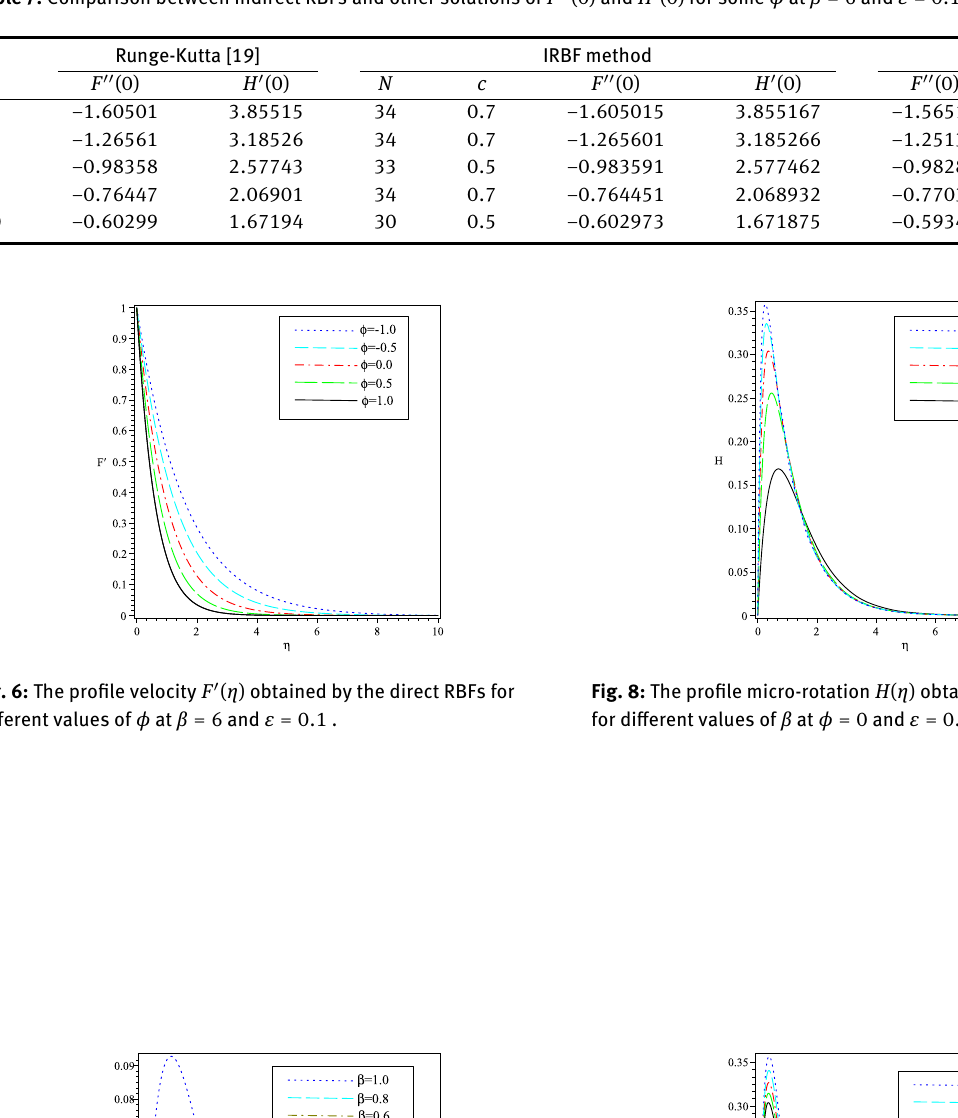
Table 7: Comparison between indirect RBFs and other solutions of F (cid:48)(cid:48) (0) and H (cid:48) (0) for some ϕ at β = 6 and ε = 0.1 .